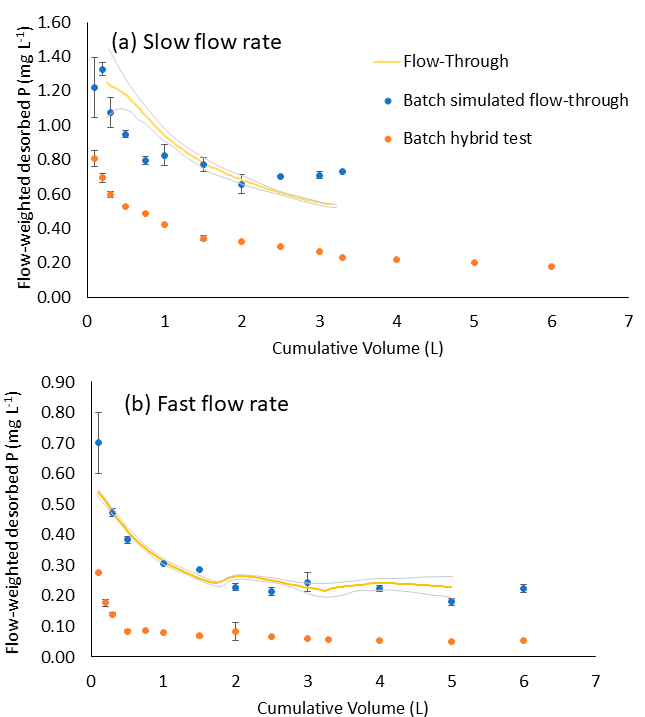
Figure 7. Mean flow-through phosphorus (P) desorption compared to the batch simulated flow- through (variable cumulative time and volume) and batch hybrid test (variable volume and constant discrete time), as a function of cumulative volume for the slow ( a ) and fast ( b ) flow rates. Flow- through solution P concentrations are flow-weighted to allow for comparison to batch methods. Error bars = standard deviation. Grey lines indicate upper and lower end of standard deviation for flow-through